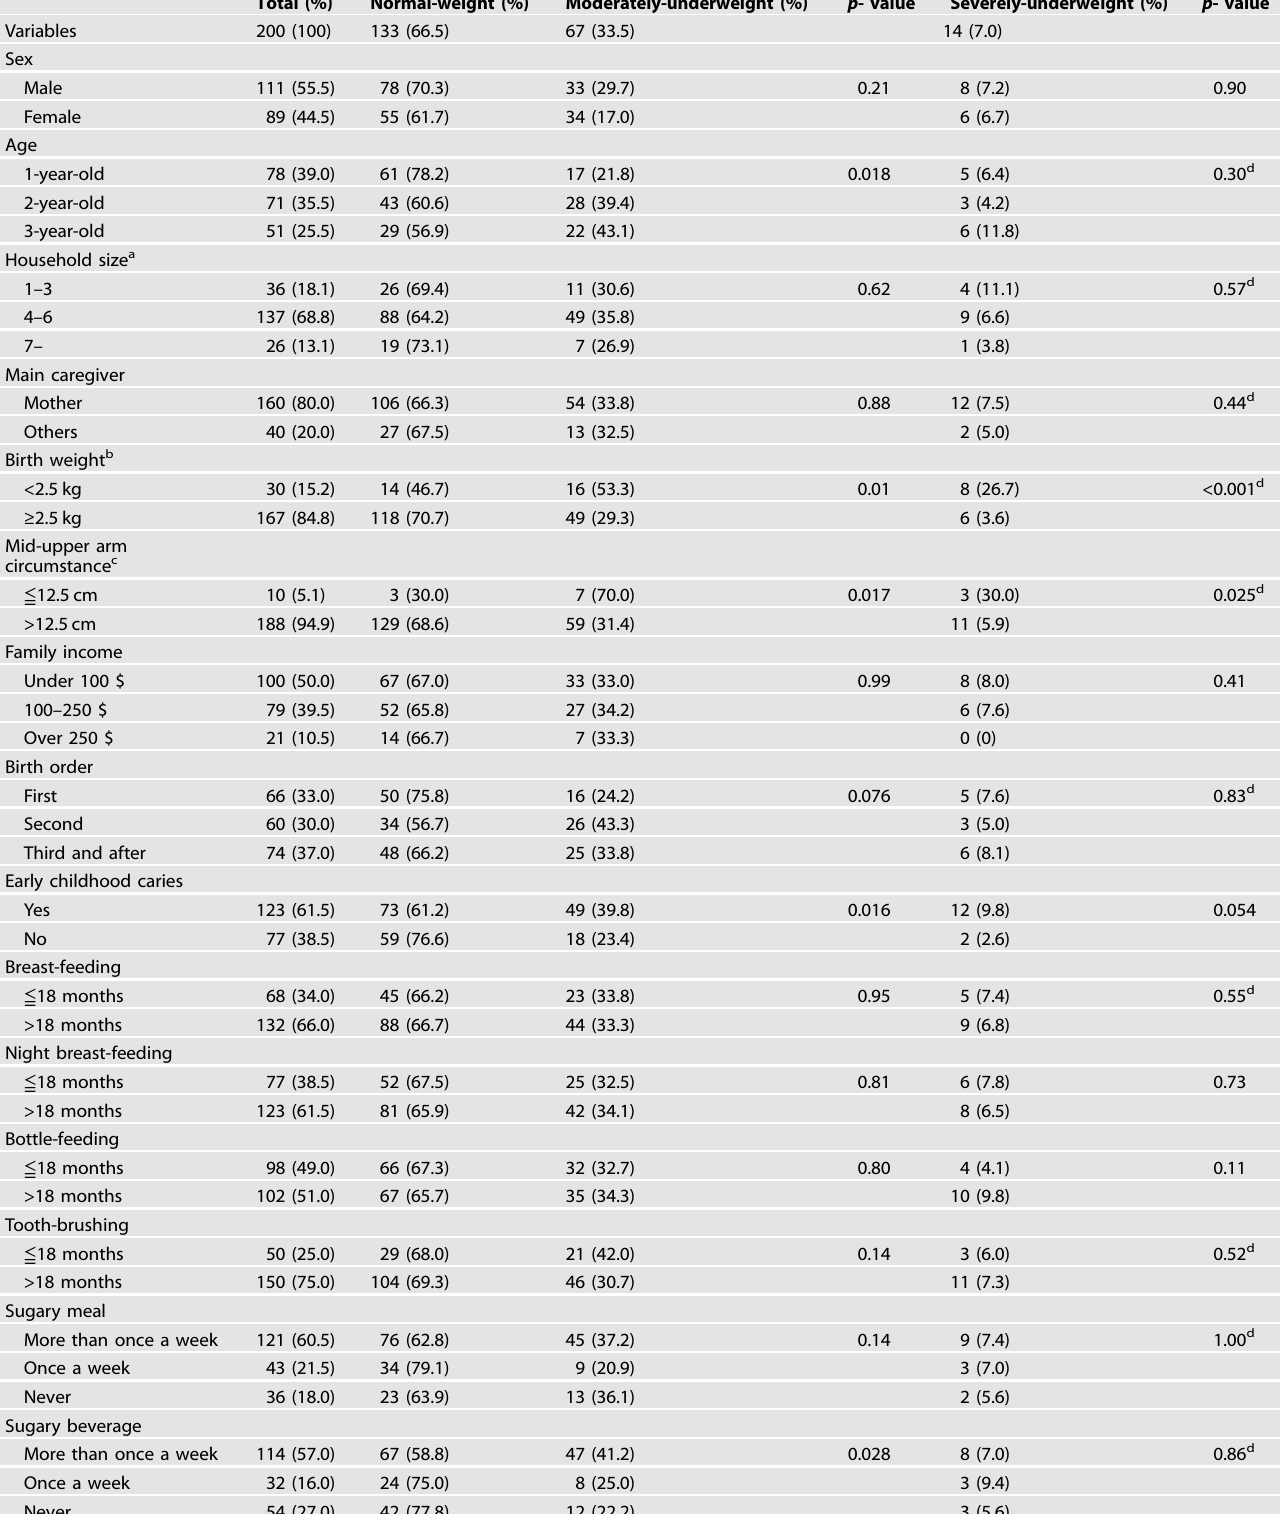
Table 1. Association between underweight status and its related factors among young children ( n = 200).